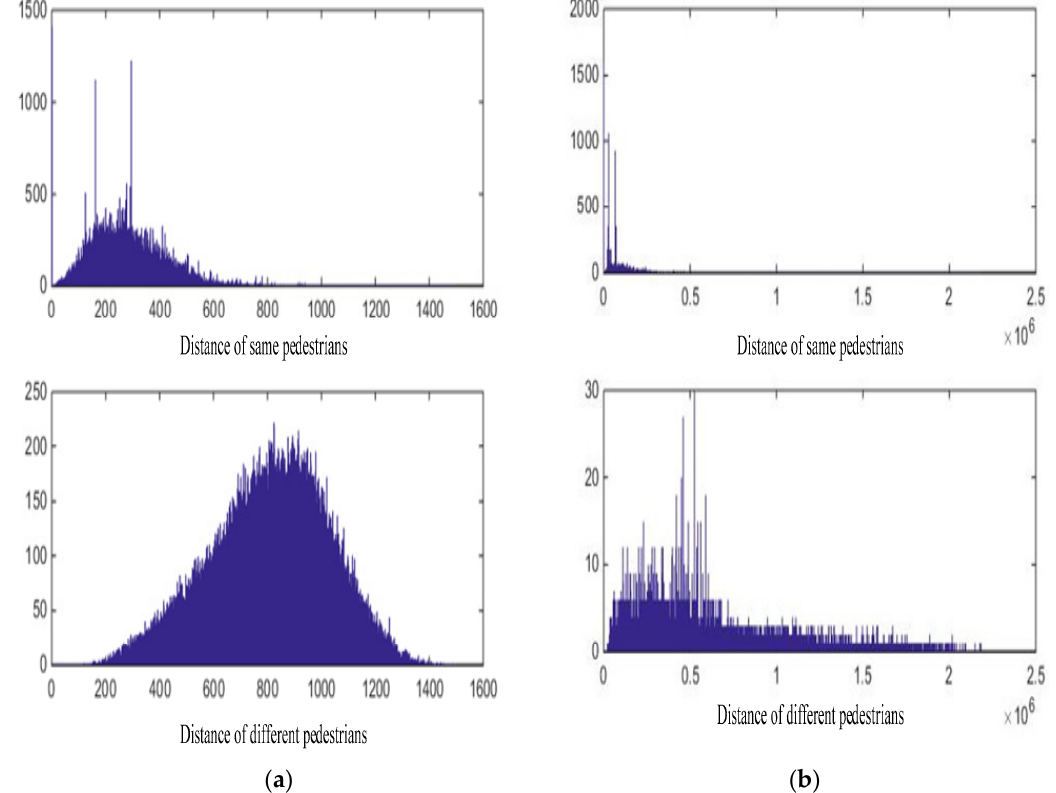
Figure 6. The statistics of the distance values. The features used in ( a ) are from sigmoid normalization, and features used in ( b ) are originally from inner-product layer.